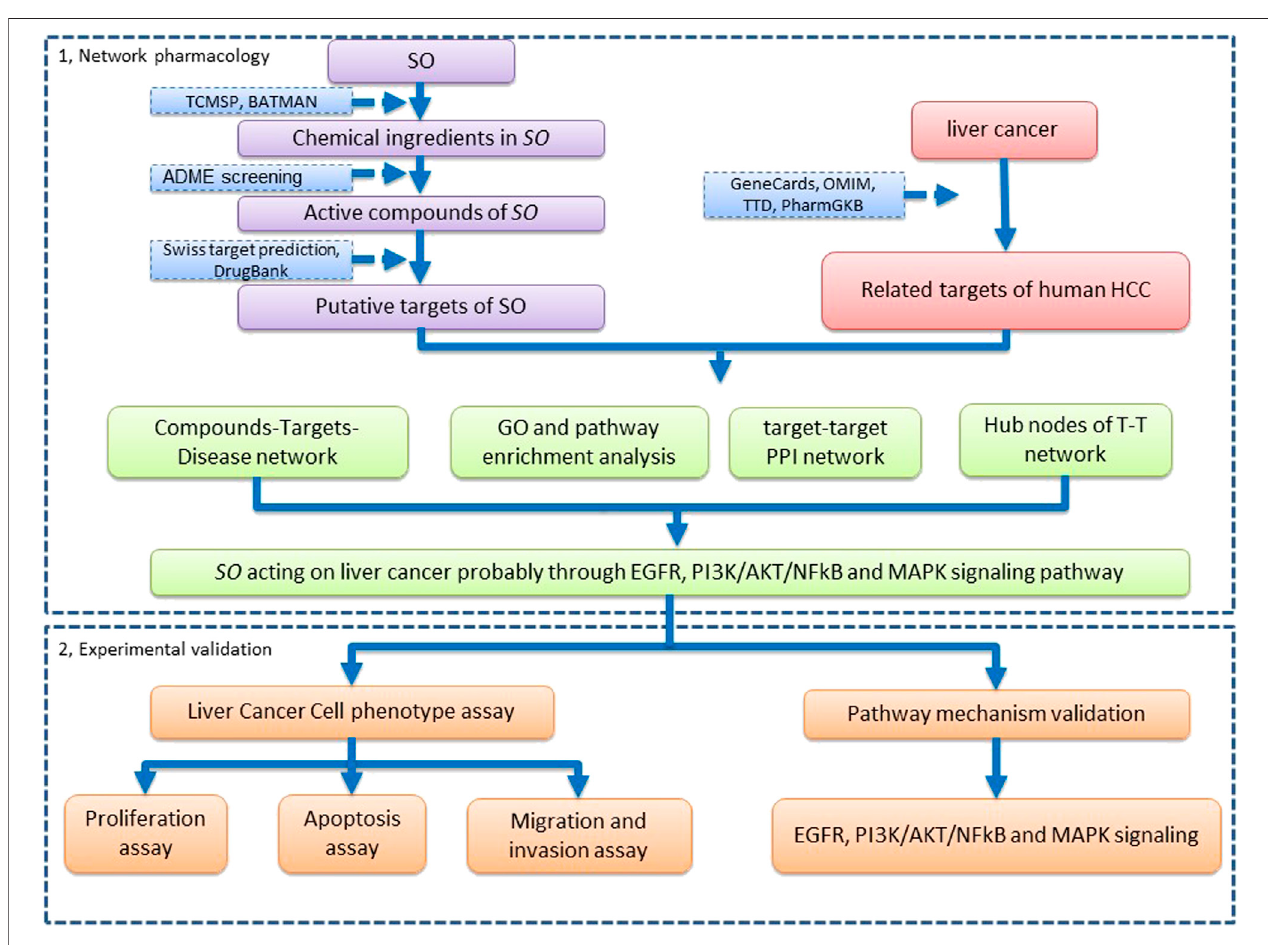
FIGURE 1 | The work fl ow of network pharmacology analysis and validation of SO on HCC.